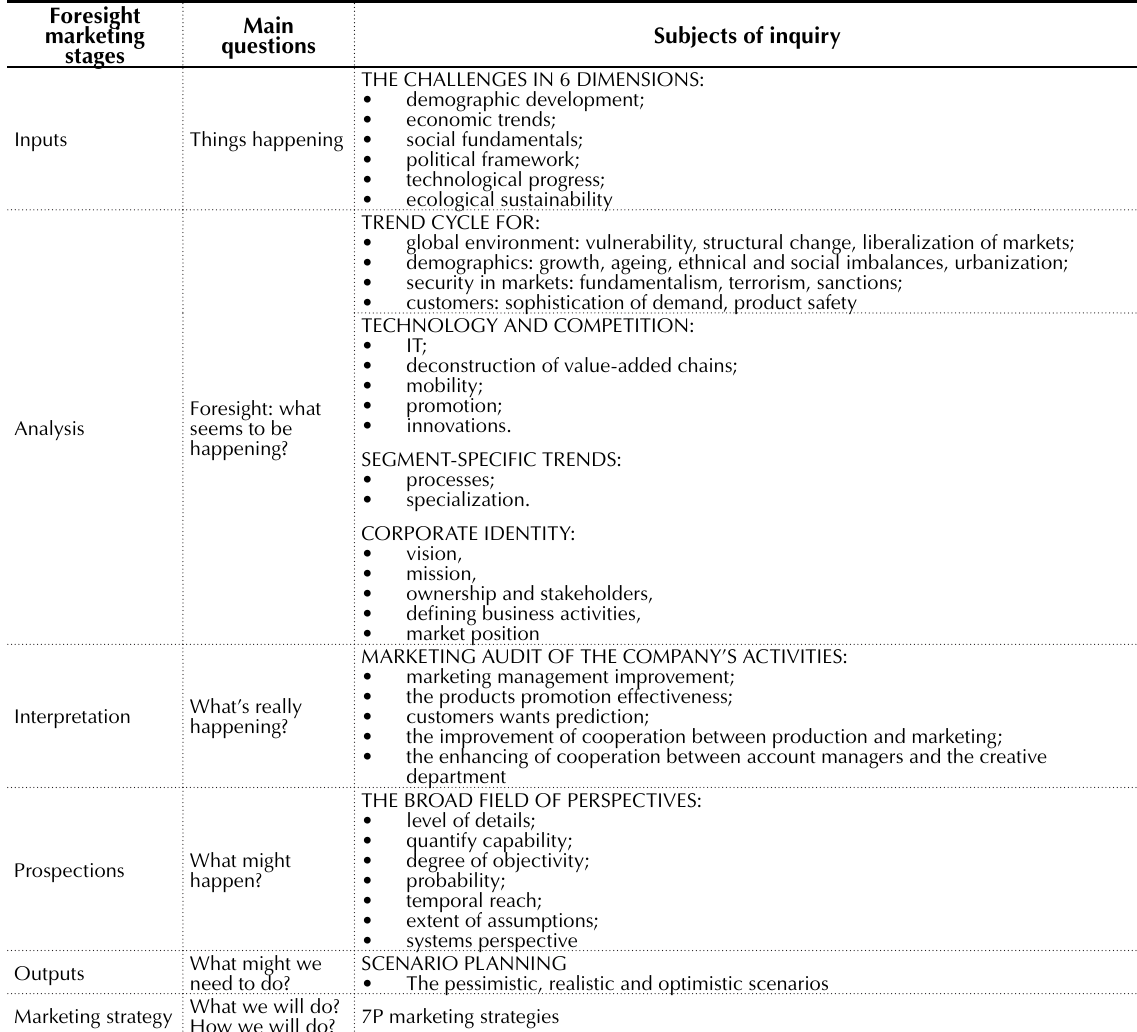
Table 1. Generic foresight-marketing